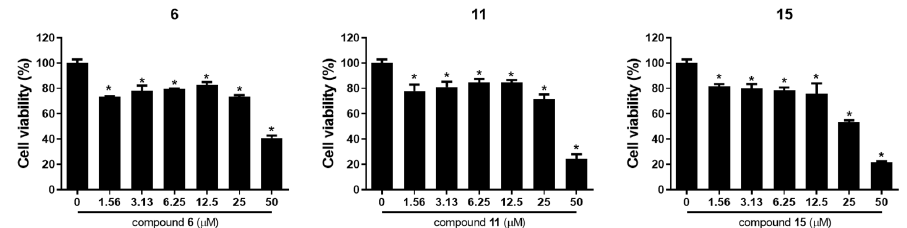
Figure 5. The effects of compounds 6 , 11 , and 15 on cell viability in epithelial ovarian cancer cells SKOV3. The results are presented as mean standard ± SD and were processed by using a one-way ANOVA. * p < 0.05 in comparison to control (0 μ M).